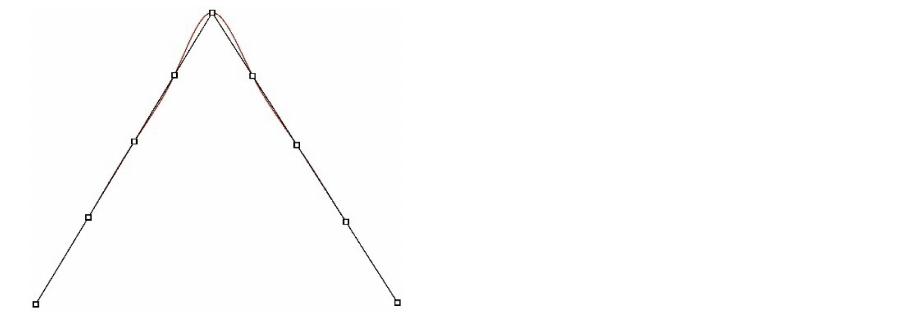
Figure 4. Influence of undulations formed in the vicinity of a kink on the segments of a spline. The number of segments is strictly related to the number of points the B-spline passes through, but only in the case of interpolation when each segment of the function passes through pairs of consecutive points. When spline models are based on laser scanning data, approximation B-spline functions are used (6) [18,22,23], which reduce the